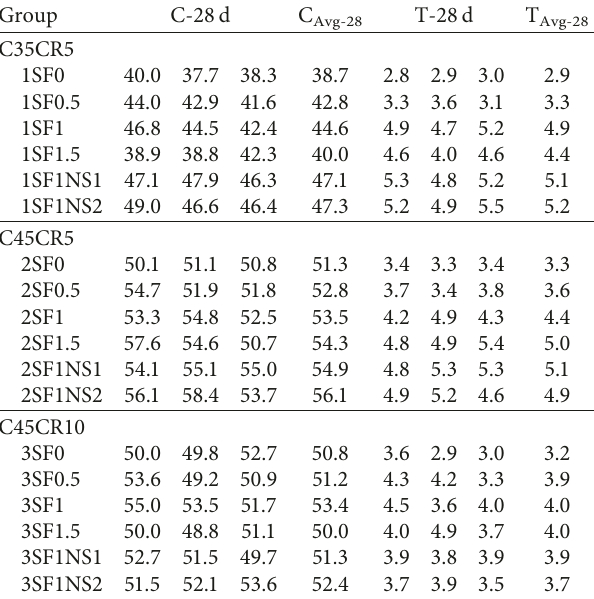
Table 4: Results of the specimens’ compressive and splitting tensile strengths tests at 28d (unit: MPa).